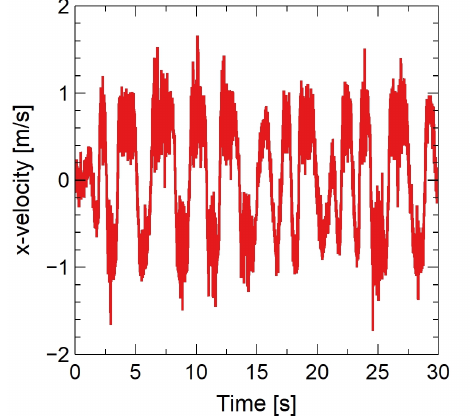
Figure 15. x velocity over 30 s for Re = 10 4 at y / B =